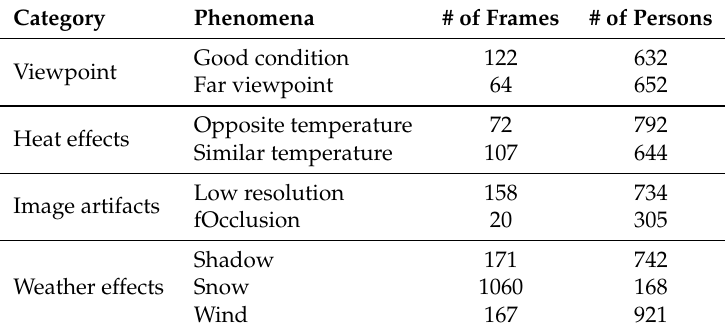
Table 2. Key characteristics of the proposed training